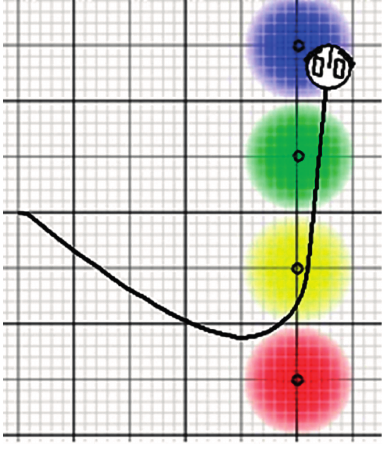
Figure 21. Braitenberg 3.c vehicle follows a path that depends on the location of the sources in the